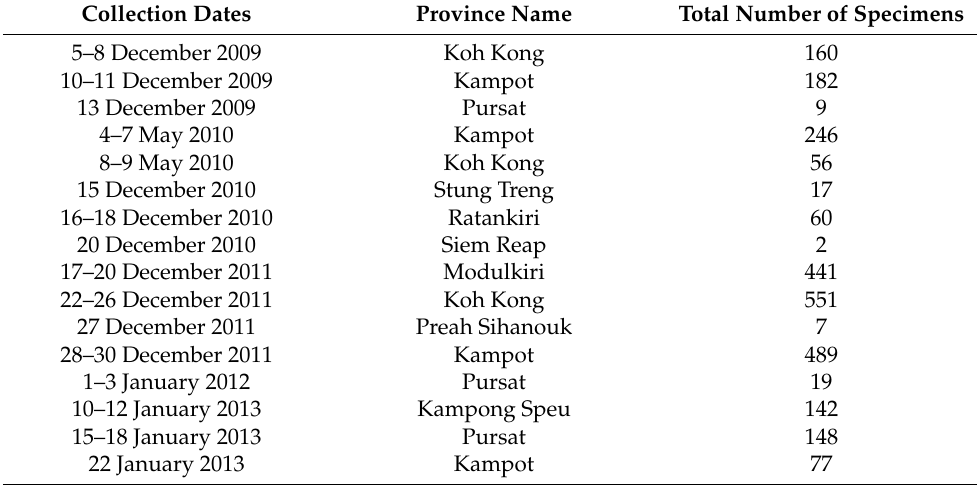
Table 1. The data on collections.